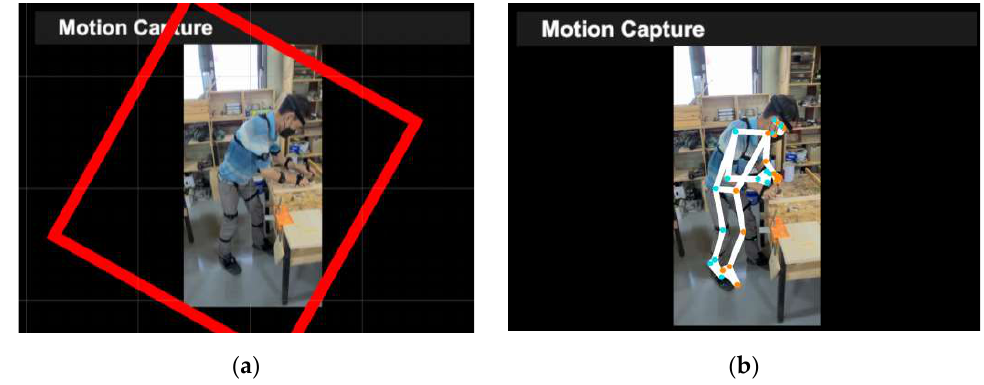
Figure 11. Detection and body estimation: ( a ) Visualization of the detected body area; ( b ) body estimation and visualization.